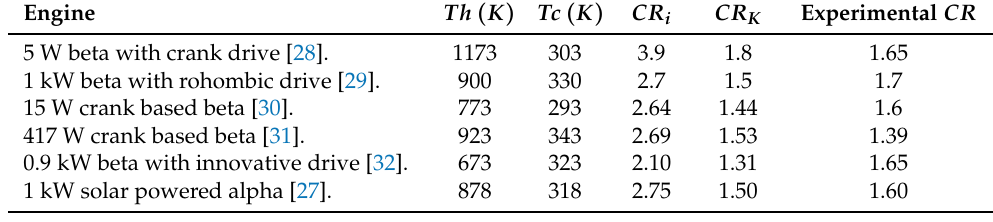
Table 2. Real engine’s CRs compared with the calculated CRs .